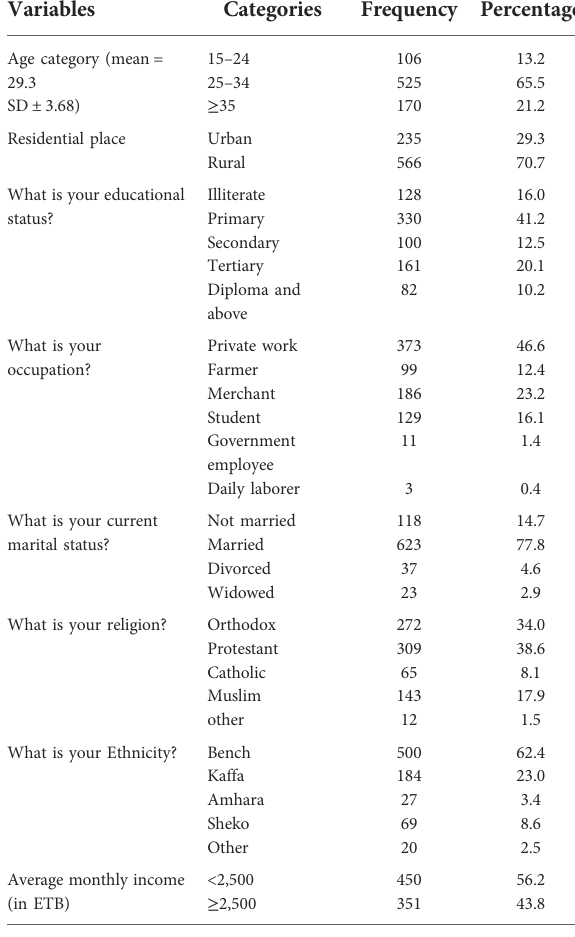
TABLE 1 Sociodemographic characteristics of male partners of women within the reproductive age group (18 – 49 years) in the Bench Sheko zone, Southwest region, Ethiopia, 2021.